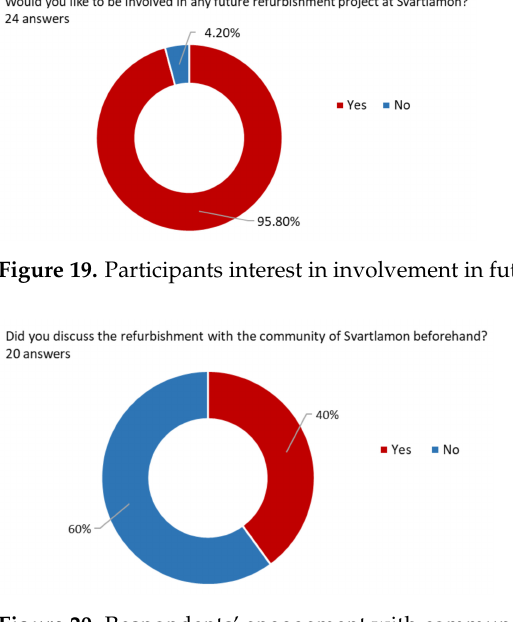
Figure 20. Respondents’ engagement with community before